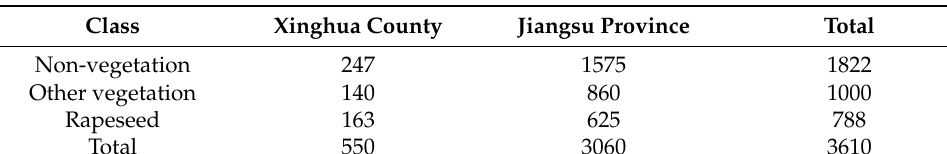
Table 2. The number of different kinds of landcovers.